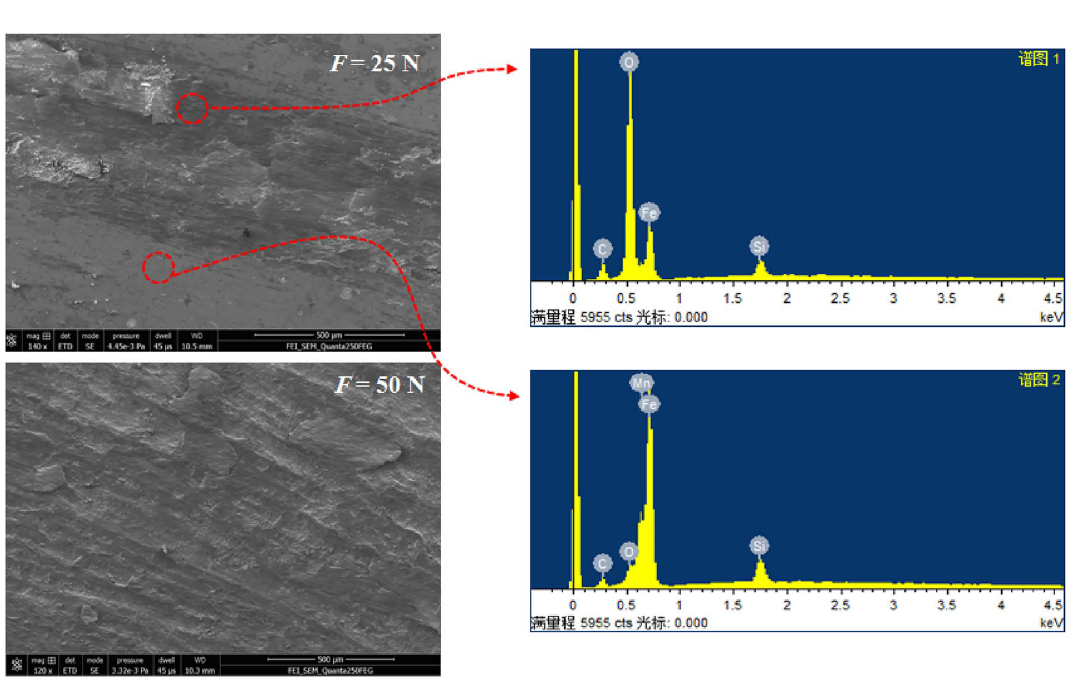
Figure 10. Wear topographies under dry lubrication